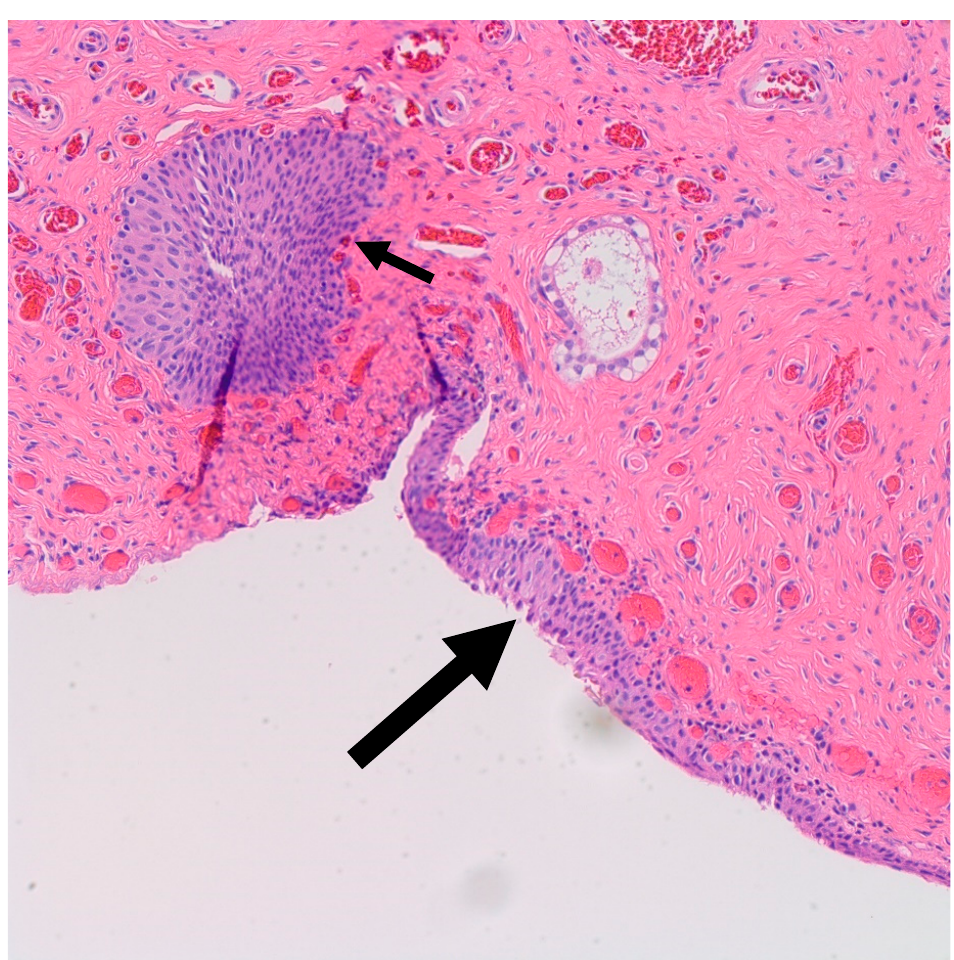
Figure 2. H&E microscopic image of transitional metaplasia (Large arrow) of surface ovarian epithelium with adjacent Walthard rest (Small arrow) (200× magnification).